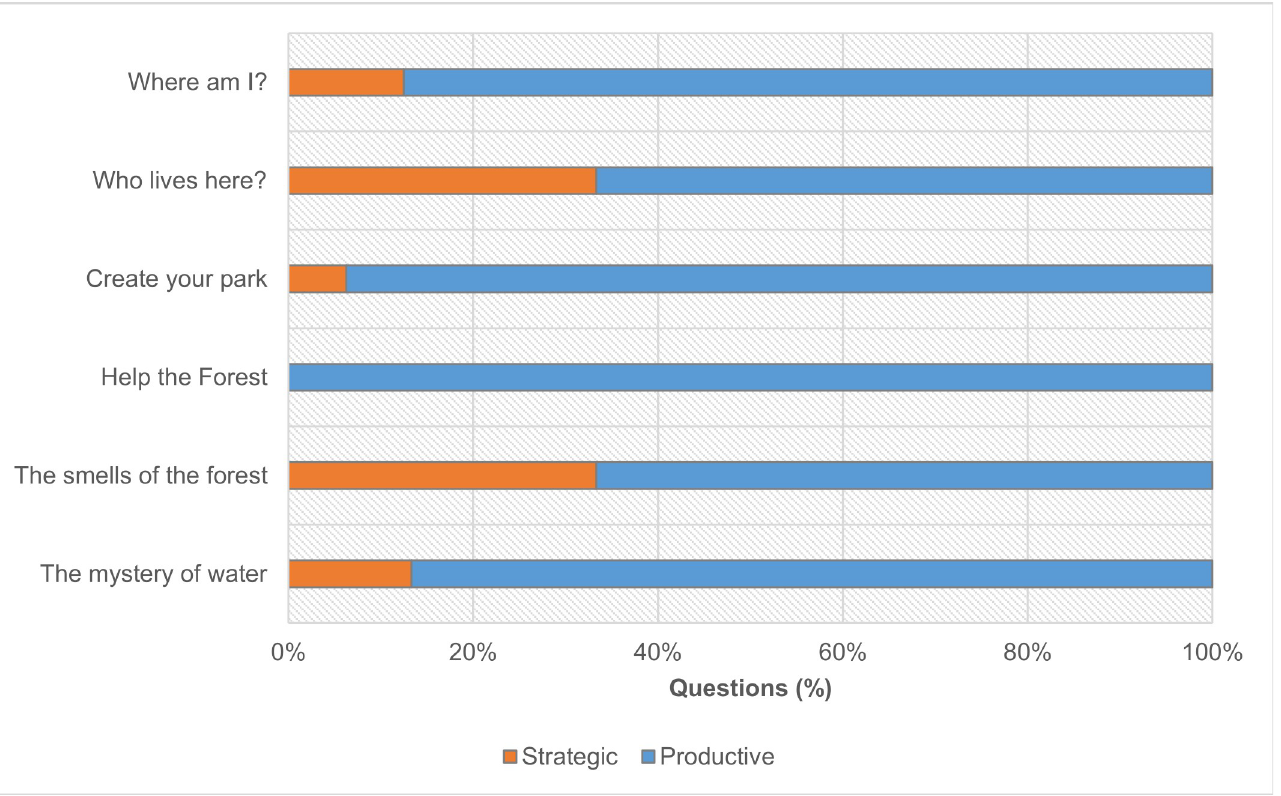
Fig 8. Distribution of ‘productive’ and ‘strategic’ questions (n = 93) of younger participants (ages 10–14) according to the stations where they were formulated (the total number of questions produced in each station varies between 15 and